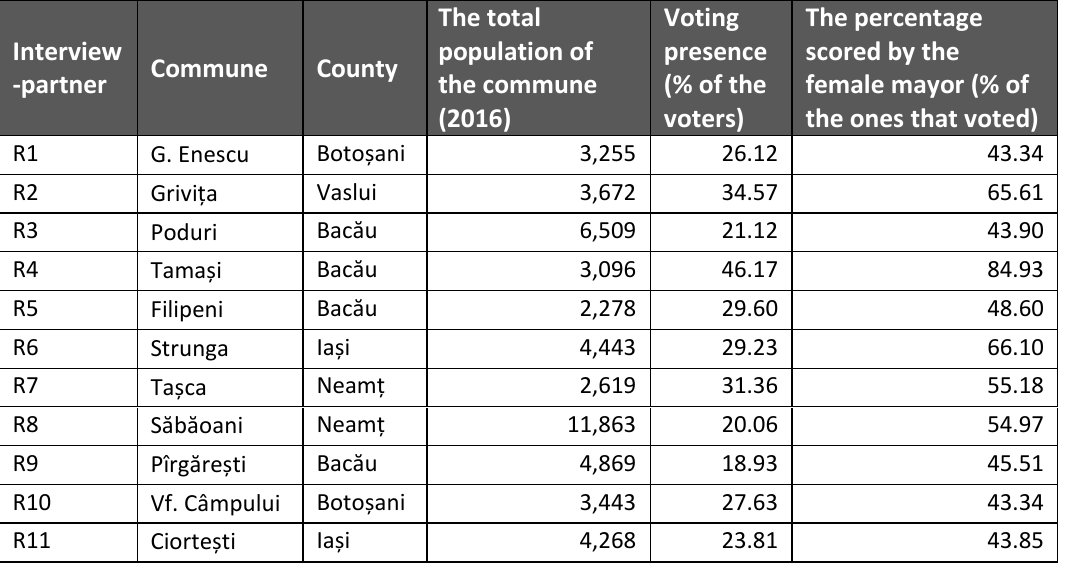
Table 3: The demographic characteristics of the studied administrative units and the electoral situation at the 2016 elections Interview Commune County -partner